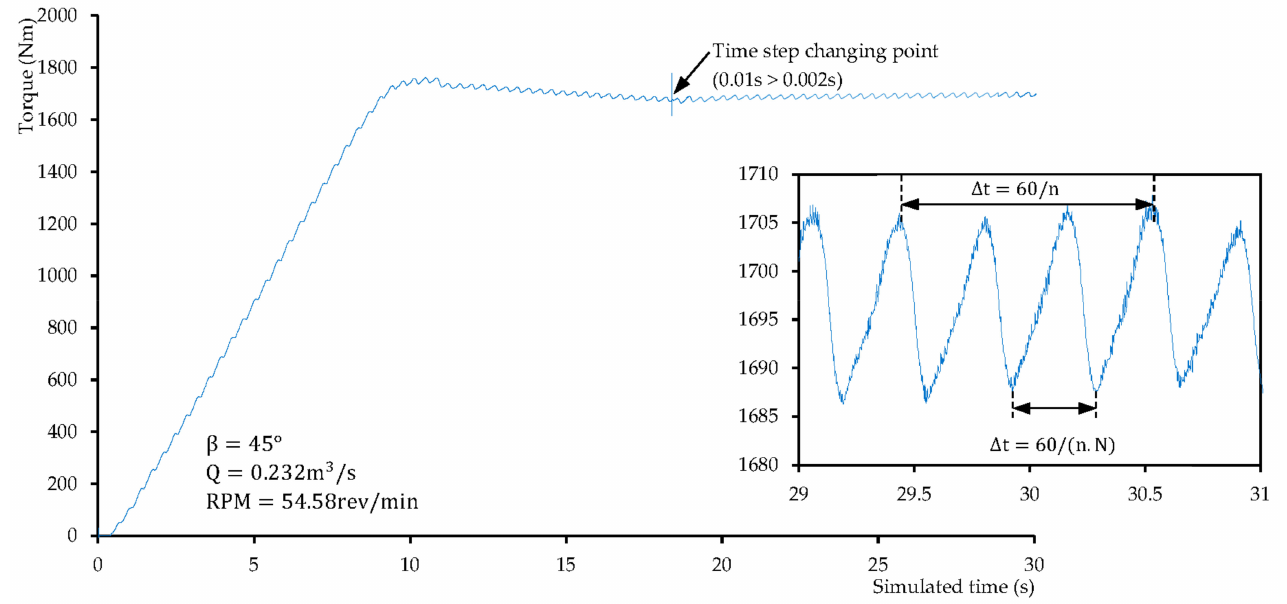
Figure 8. Ansys CFX 19.2 solve result of torque variation for AST operates at 54.58